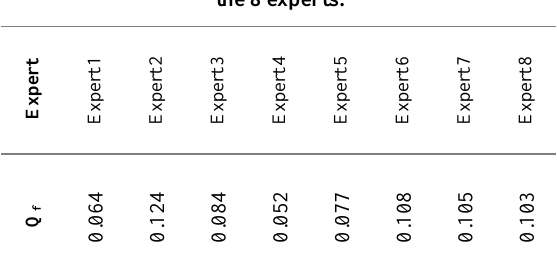
Table 6. Reliability of the input data for each one of the 8